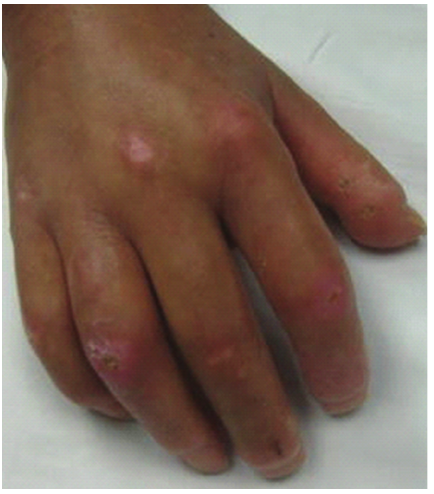
Figure 2: Traumatic